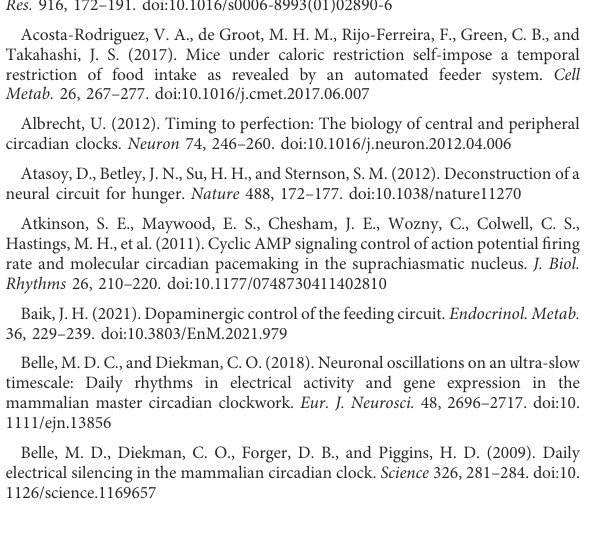
Control for the injection of FLP recombinase into the PVN region. Detection of Cherry (red) and Avp (Alexa 568, yellow) in the PVN region of control AAV-injected mice, or mice injected with an AAV allowing retrograde transport of the FLP recombinase and Cherry. ×40 objective (numerical aperture = 1.25, oil), a white bar measures 100 μ